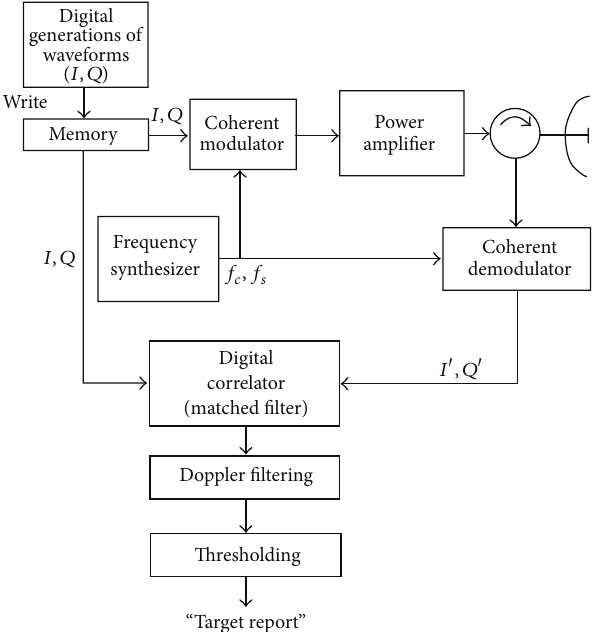
Figure 7: General architecture of solid-state, coherent, NRT-based marine